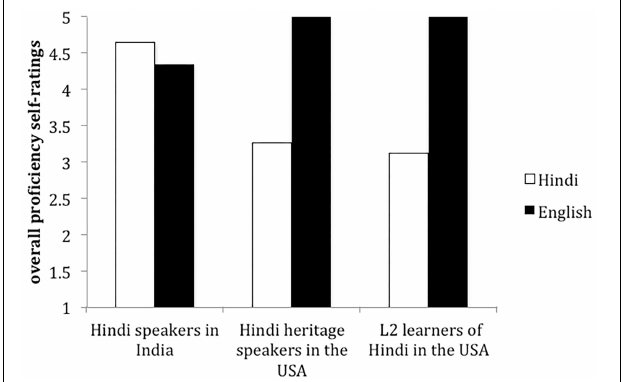
FIGURE 1 | Dominance profiles of the bilinguals